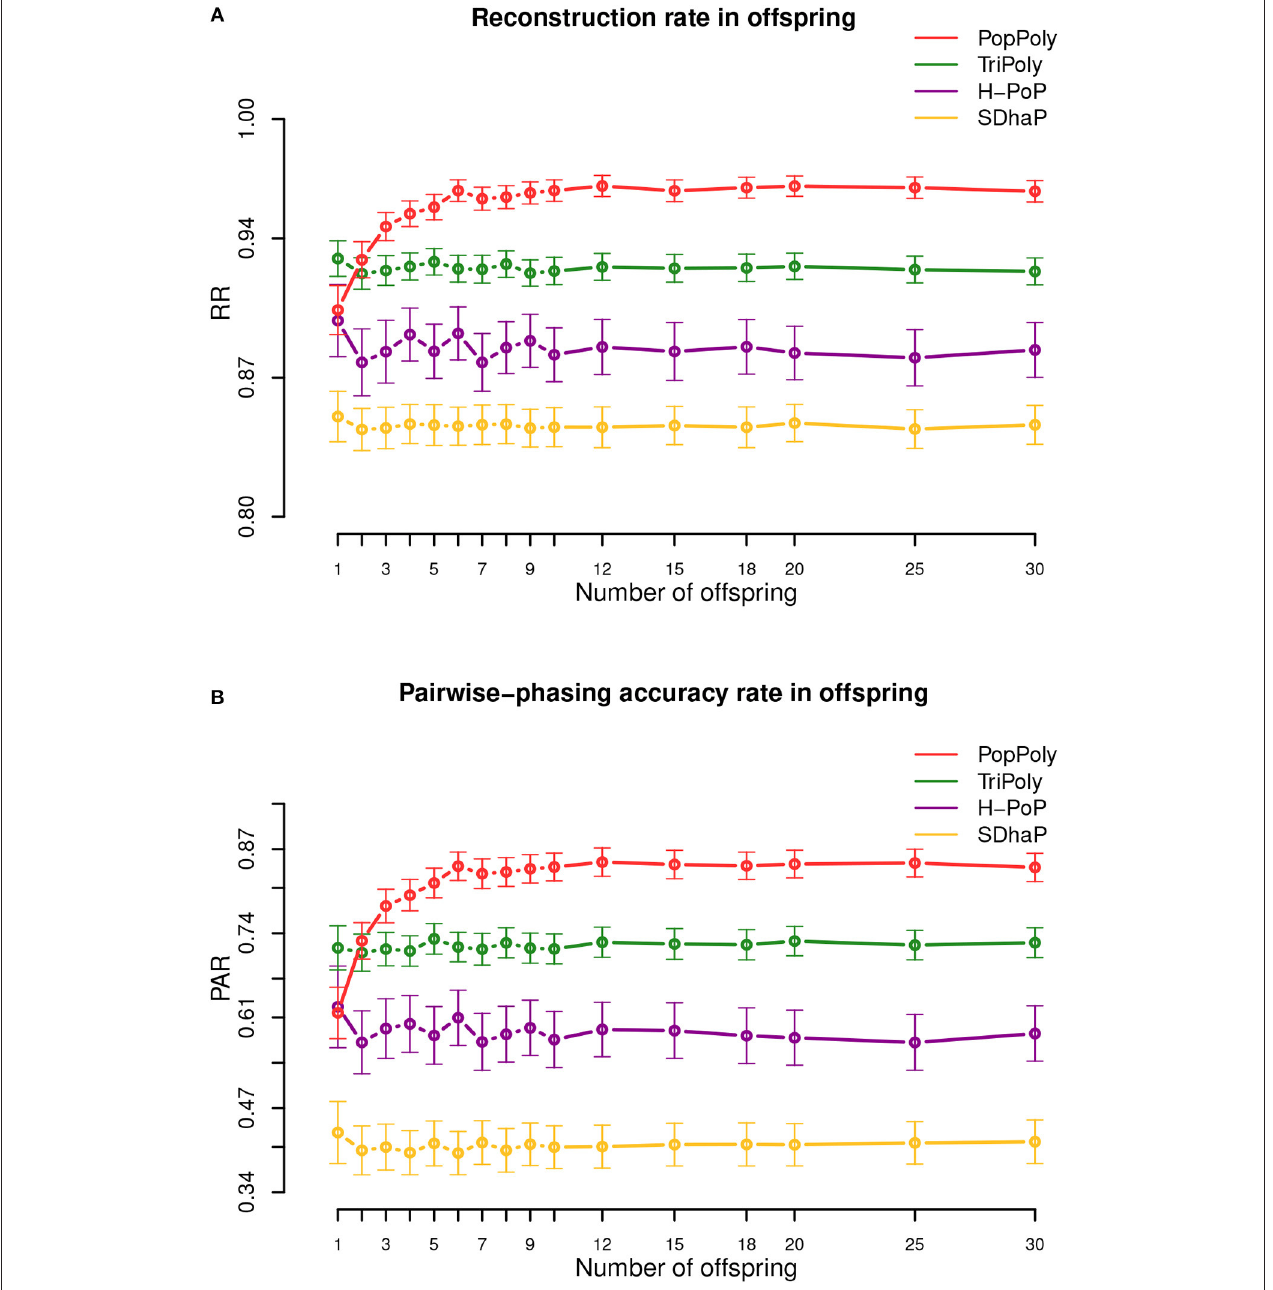
FIGURE 2 | Haplotyping accuracy measures: (A) RR, (B) PAR in the offspring against the number of offspring in the population using PopPoly (red), TriPoly (green), H-PoP (purple), and SDhaP (yellow) for simulated tetraploid potato populations.